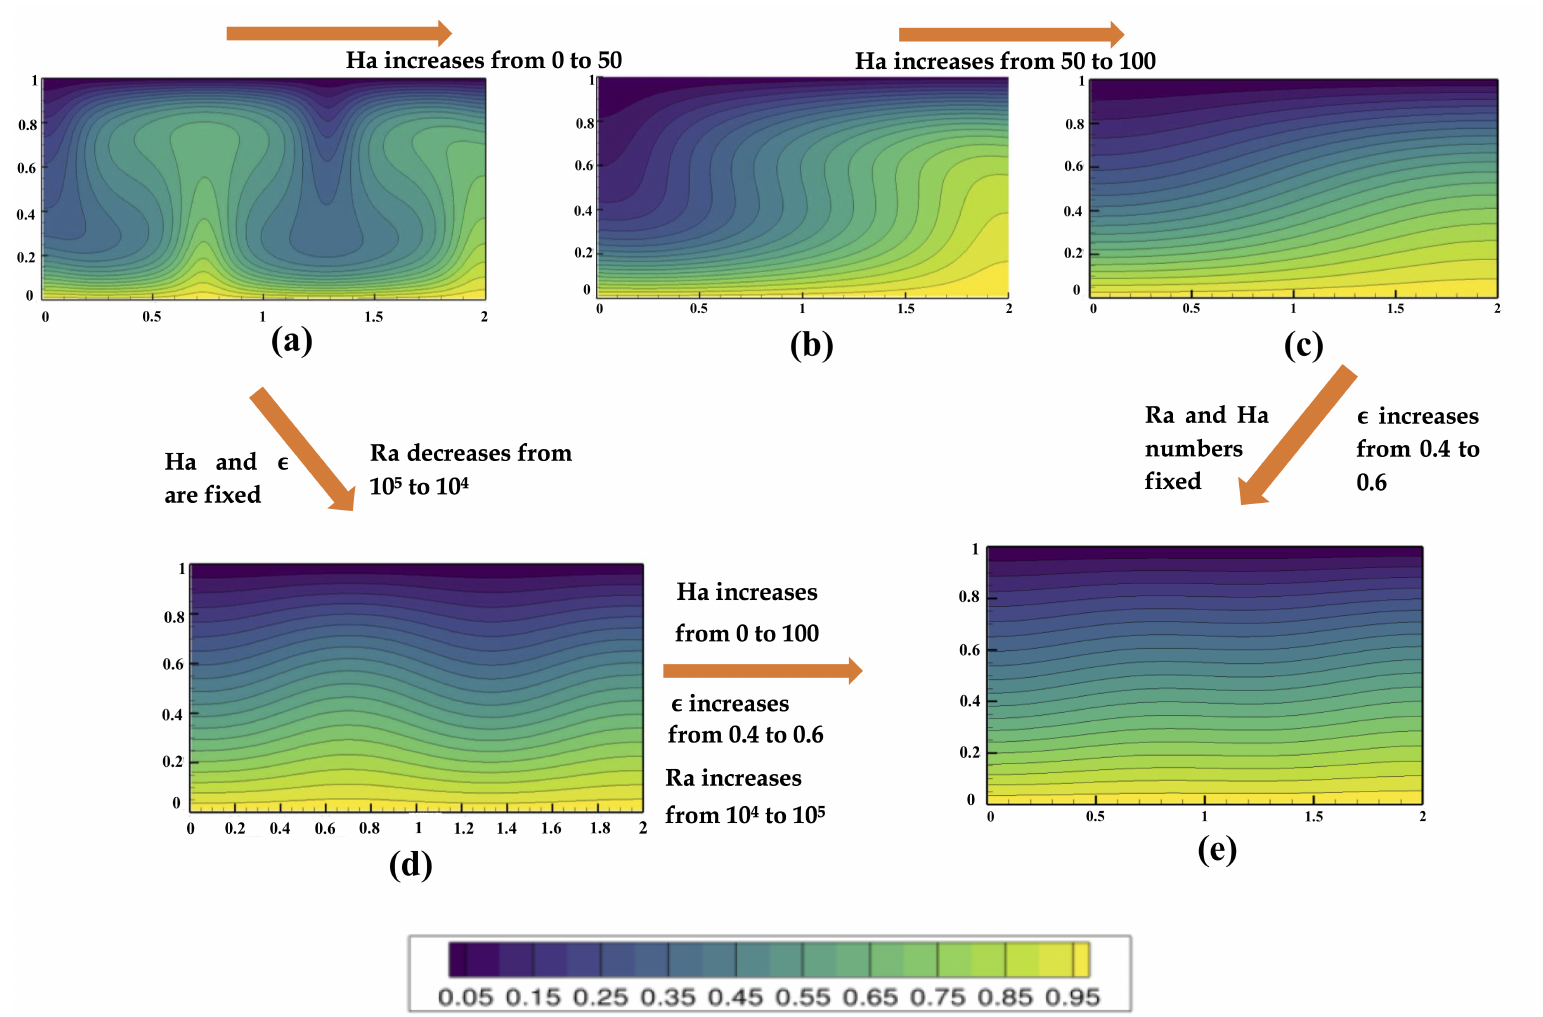
Figure 4. Representation of isotherms as Ra , Ha numbers, and (cid:101) changed under constant θ = 0, and Da = 10 − 2 : ( a ) Ra = 10 5 , (cid:101) = 0.4, and Ha = 0, ( b ) Ra = 10 5 , (cid:101) = 0.4, and Ha = 50, ( c ) Ra = 10 5 , (cid:101) = 0.4, and Ha = 100, ( d ) Ra = 10 4 , (cid:101) = 0.4, and Ha = 0, ( e ) Ra = 10 5 , (cid:101) = 0.6, and Ha =